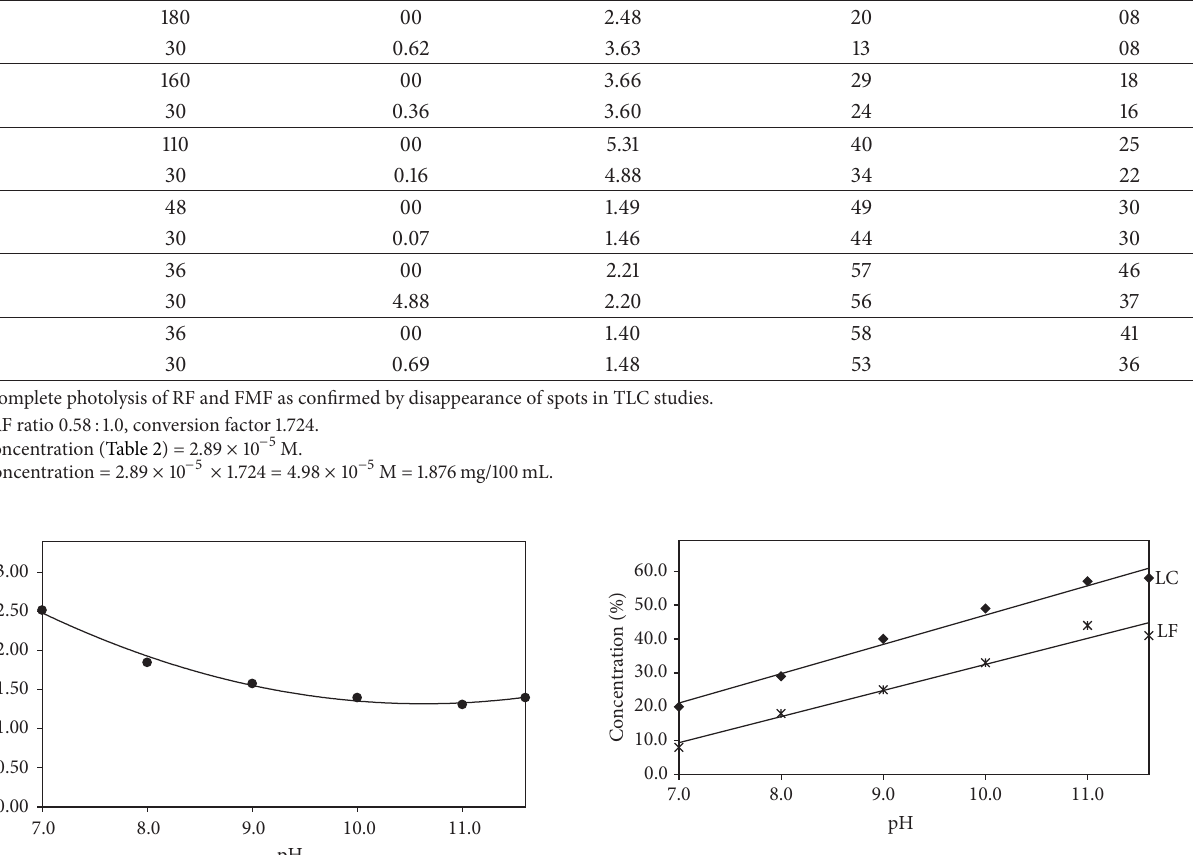
Figure 2: A plot of % concentration of LC ( X ) and LF ( ∗ ) formed versus